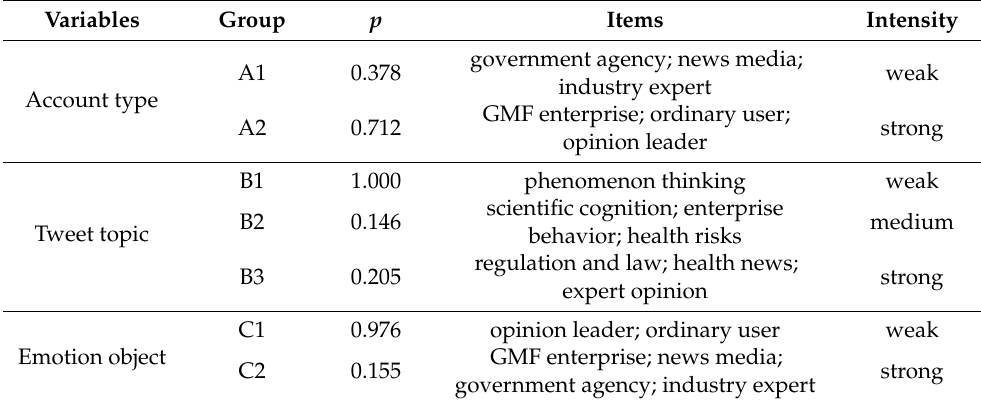
Table 4. Student–Newman–Keuls (SNK) test results of emotion